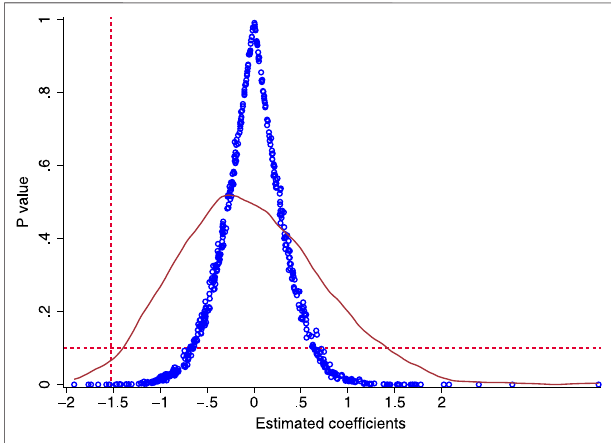
FIGURE 9 | Placebo trend test result of thermal power